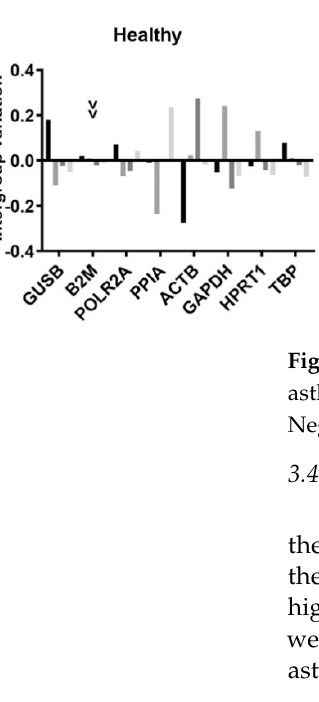
Table 1. Ranking of potential RGs according to stability values calculated with different algorithms.